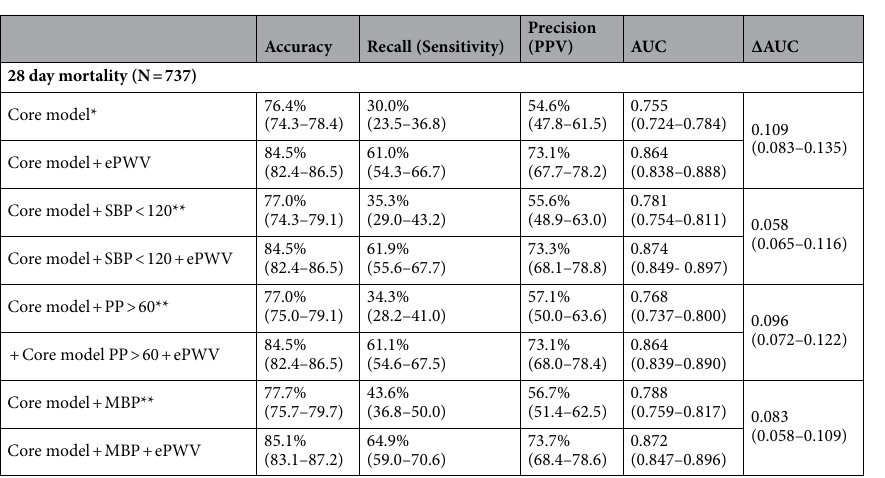
predictor of mortality in COVID-19 infection reflecting a cumulative combination of aging, high-risk cardio- vascular profile including HMOD and acute vascular dysfunction. Arterial stiffening is an aging process of the vascular network which is accelerated mainly by hypertension and renal dysfunction 14–16 but also by other factors such as smoking, diabetes mellitus (DM) and dyslipidemia 17 . Arterial stiffening adversely affects arterio-ventricular coupling leading to heart failure 18 , intercorrelates with